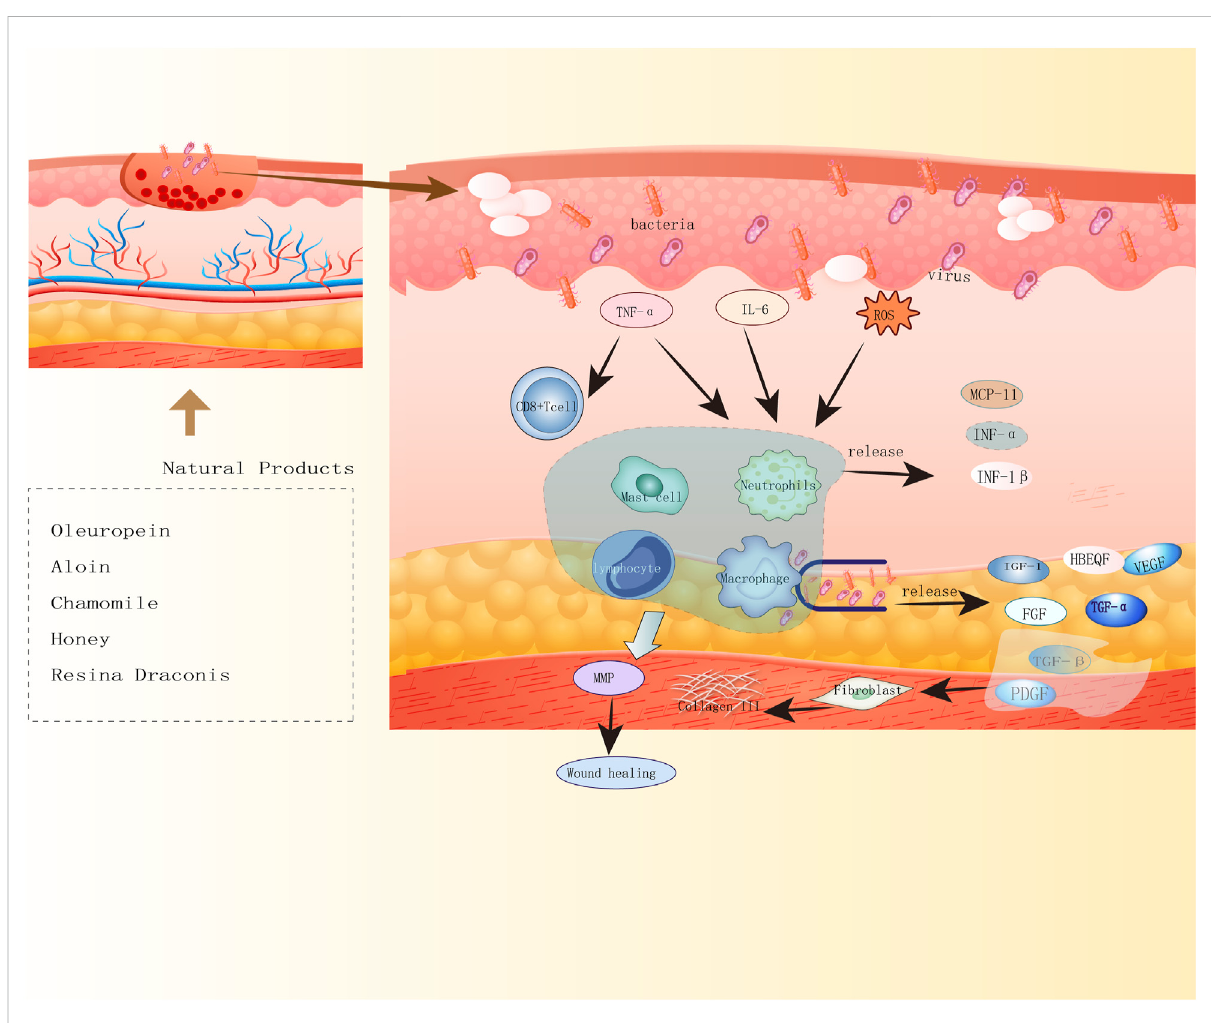
FIGURE 2 Diagram ofnaturalproductantimicrobialmechanisms. Fivenaturalproducts ofoleuropein,aloin,chamomile,honey, Resina Draconispromote wound healing by antibacterial, antiviral